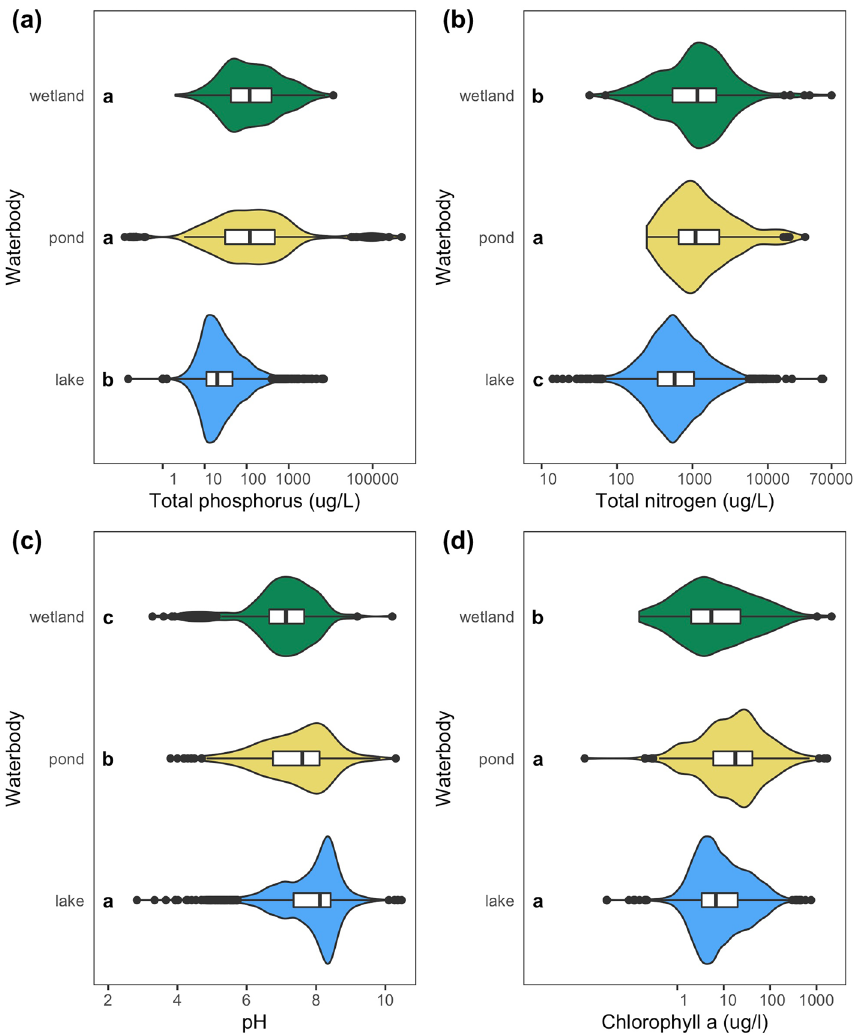
Figure 4. Comparison of various chemical and biological parameters across wetlands, ponds, and lakes, with waterbody category based on the term used by publishing scientists and managers (Table S2). Violin plots indicate distributions of waterbody characteristics, the white box indicates 25th to 75th percentile with median in the middle, whiskers indicate 1.5 × interquartile range, and outliers are black closed circles. Letters inside the plot indicate significant differences in means (LSD, alpha = 0.05). Note all x-axes have logarithmic